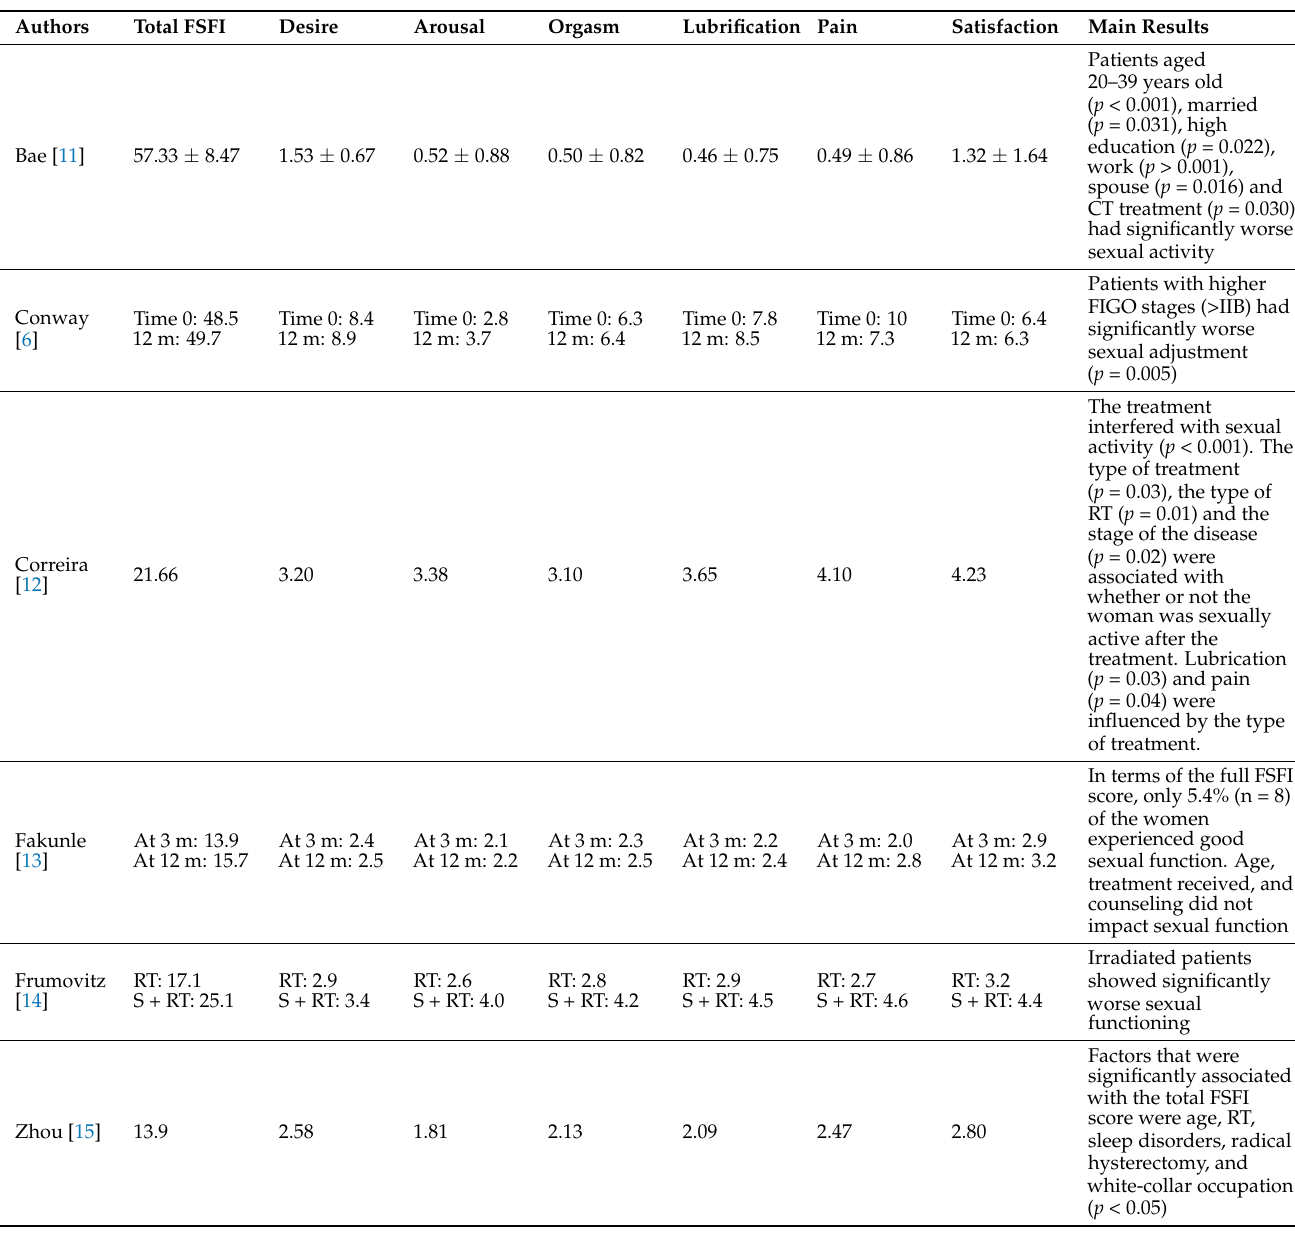
Table 2. Female sexual functioning index